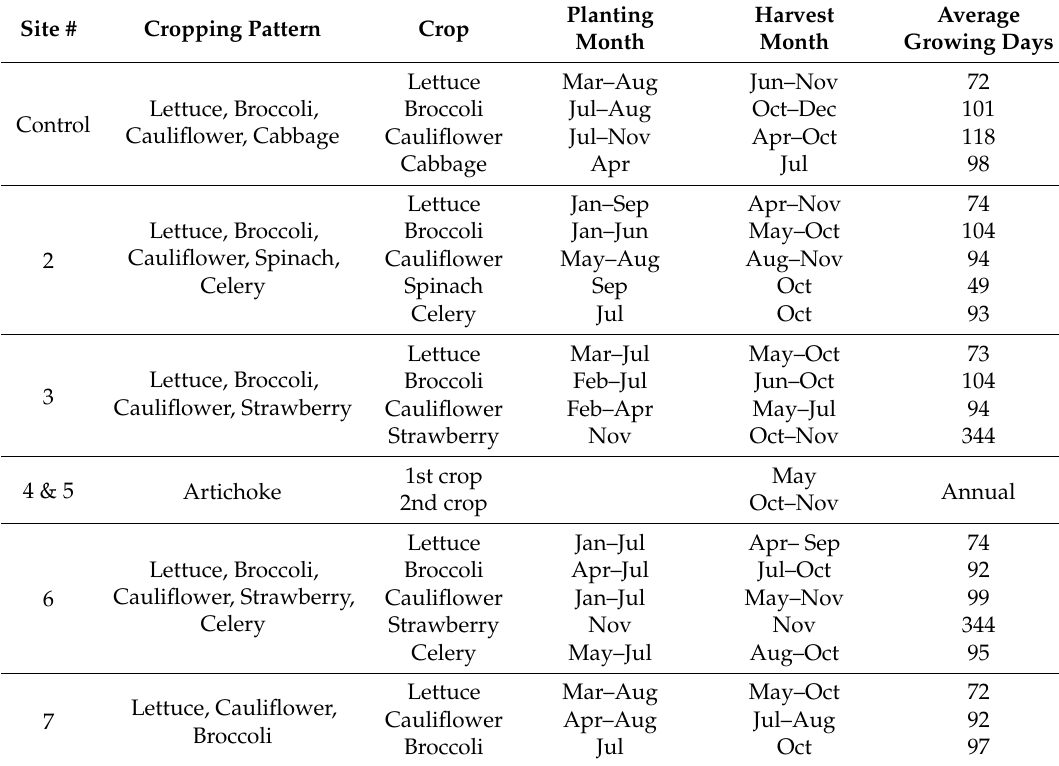
Table A1. Cropping patterns for the control site and sites irrigated with treated wastewater.